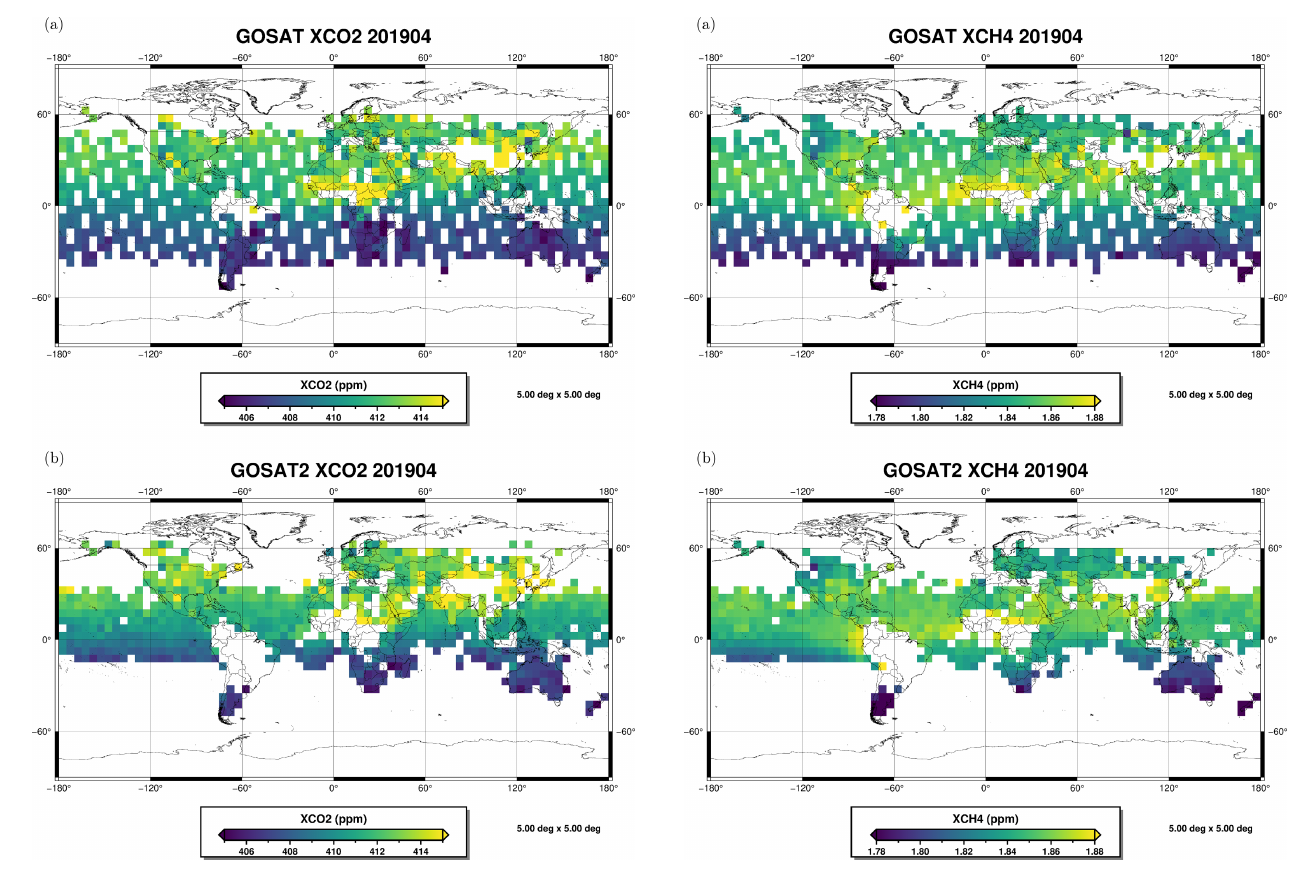
Figure 3. Maps of gridded XCO 2 data for April 2019: (a) GOSAT; (b) GOSAT-2.